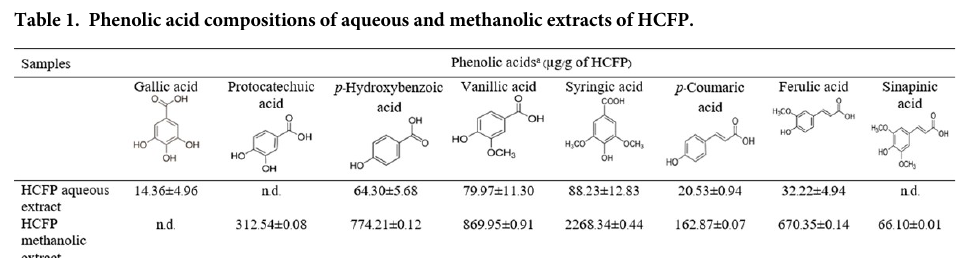
a Results are expressed as means ± SD of three determinations. n.d., not